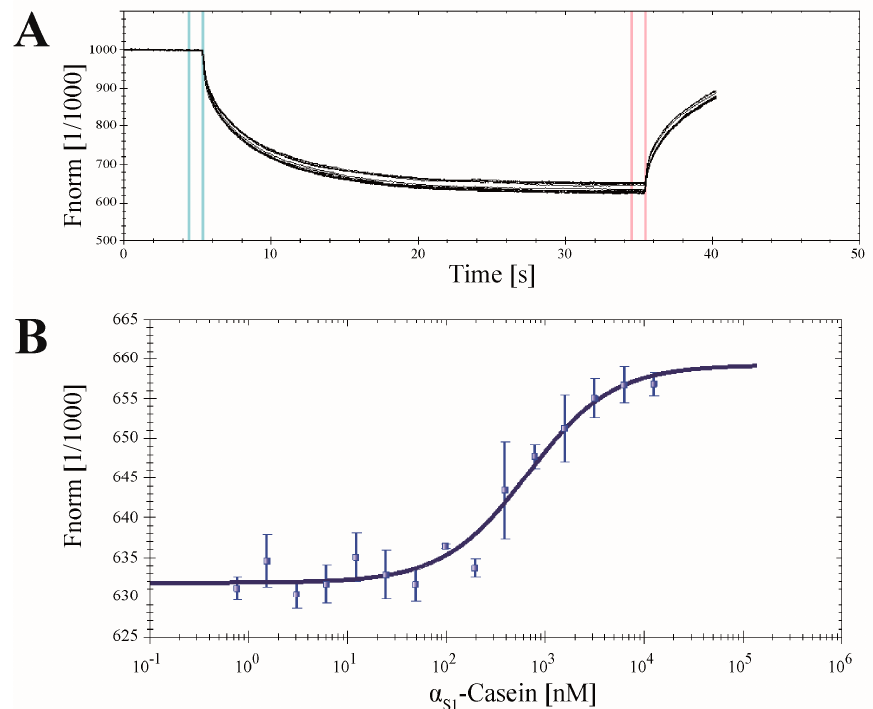
Figure 10. Interaction of CK2 α -DBCO-Sulfo-Cy5 and human α S1 -casein. To a constant amount of CK2 α (65 nM) α S1 -casein was titrated in different concentrations, ranging from 0.76 nM to 12.50 µM. ( A ) The normalized fluorescence signals of the thermophoresis of 15 different dilutions of α S1 -casein in presence of the CK2 α subunit were recorded. ( B ) The K D value of 631 ± 86.2 nM was determined